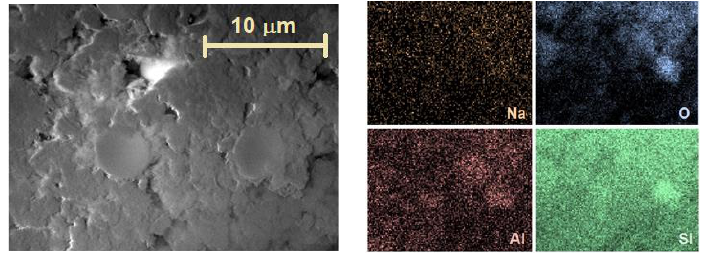
Figure 4. Element distribution maps in the MOR-P sample.